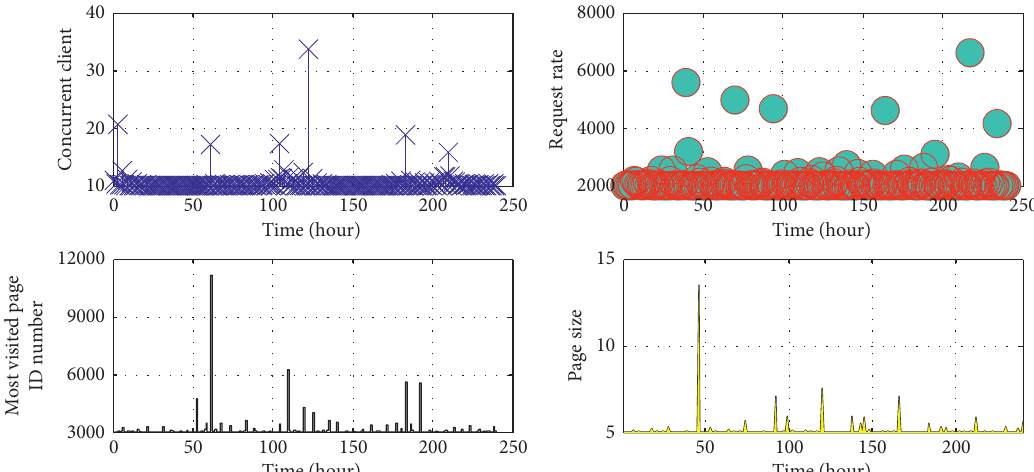
Figure 5: Visualization of load generation